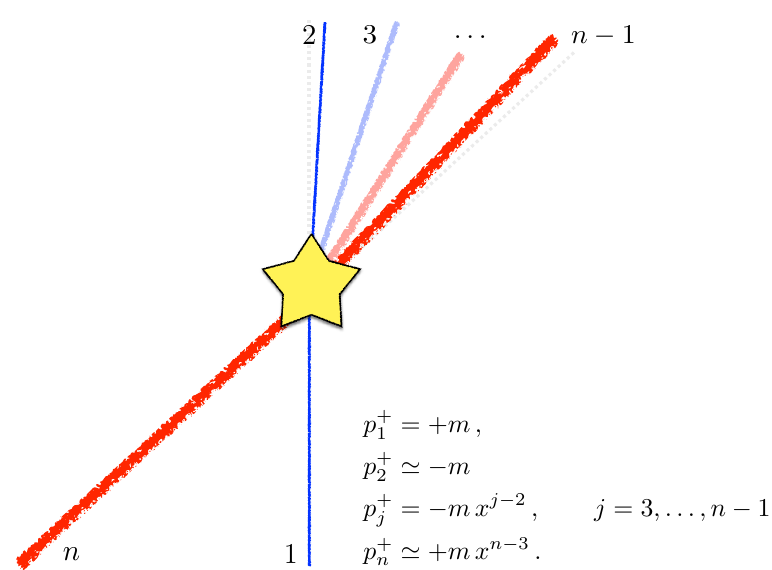
Figure 1 . The precise expression for the momenta of particles 2 and n are given by solving energy-momentum conservation P p + = P 1 =p + = 0. In the multi-Regge limit with x 1 we j j (cid:29) have a highly energetic particle hitting a particle at rest producing a particle which is almost at rest plus a shower of very energetic particles. (More precisely, one (cid:12)nds the momenta p + = n p + p + + O ( x (cid:0) 1 ) mx n (cid:0) 3 and p (cid:0) = p (cid:0) p (cid:0) p (cid:0) + O ( x 2 (cid:0) n ) m .) n 1 (cid:0) (cid:1) (cid:1) (cid:1) (cid:0) 3 2 1 (cid:0) 3 (cid:0) (cid:1) (cid:1) (cid:1) (cid:0) n 2 (cid:0) ’ (cid:0) ’ (cid:0) (cid:0) (cid:0)